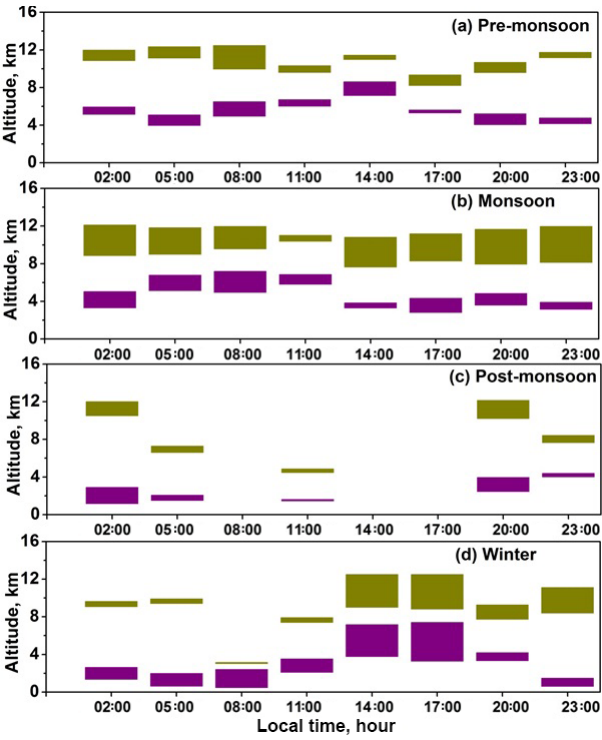
Figure 6. Diurnal variations of mean vertical locations (base and top) and thicknesses of one-layer clouds observed during (a) pre- monsoon, (b) monsoon, (c) post-monsoon, and (d) winter seasons.